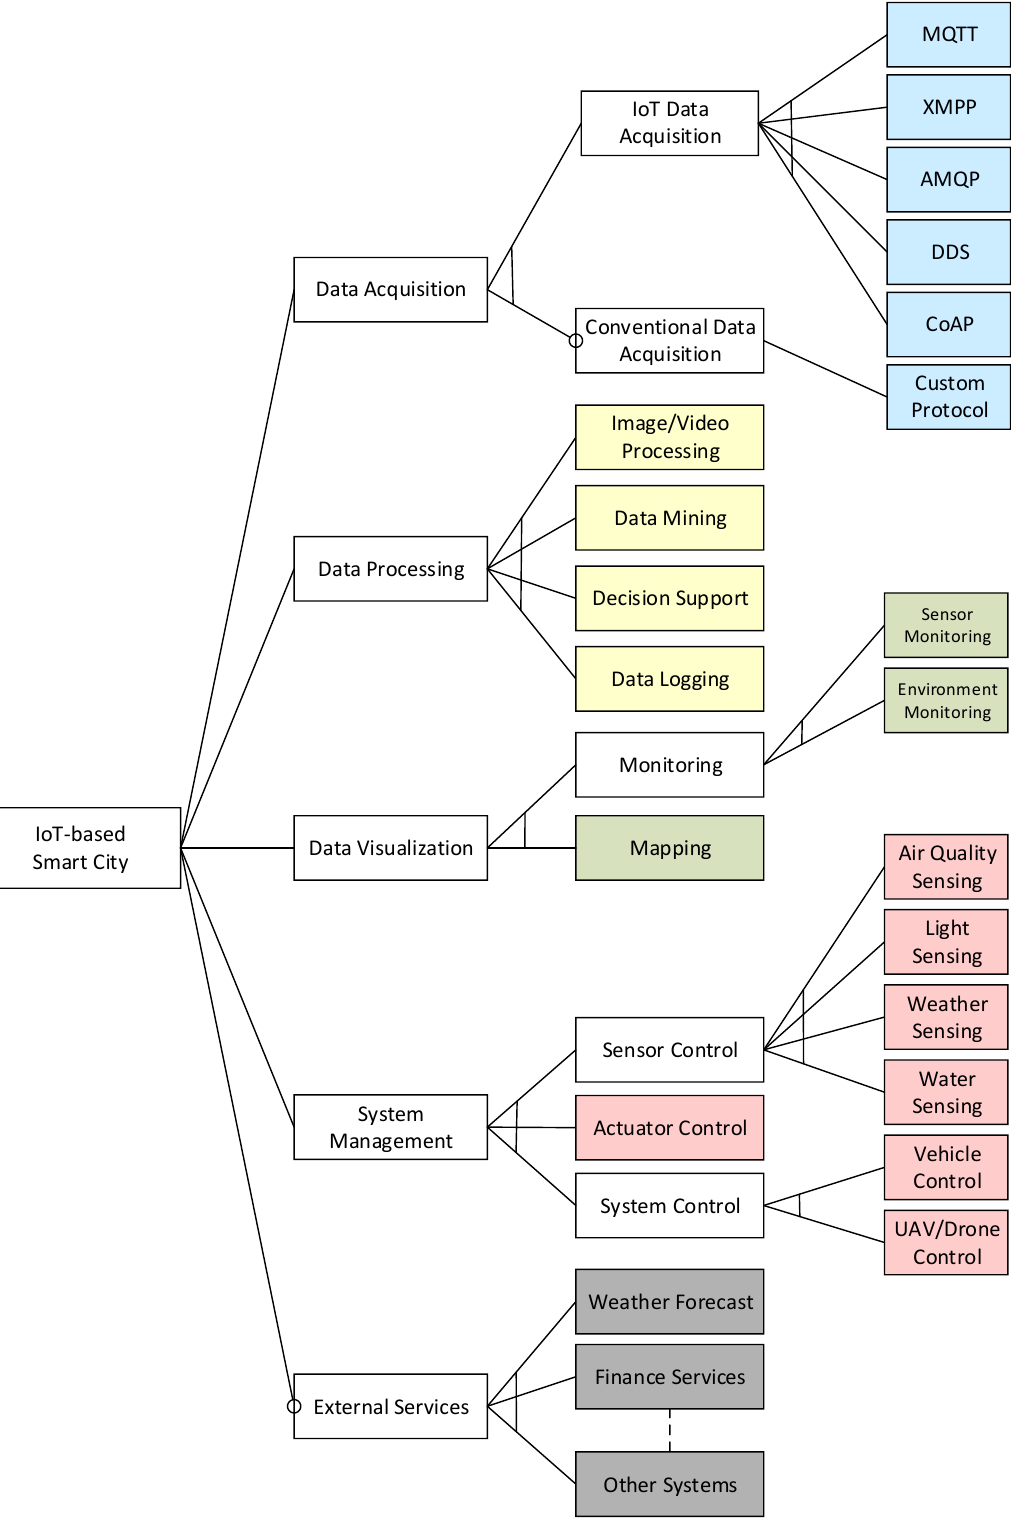
Figure 3. Feature Model for IoT-based Smart Cities .